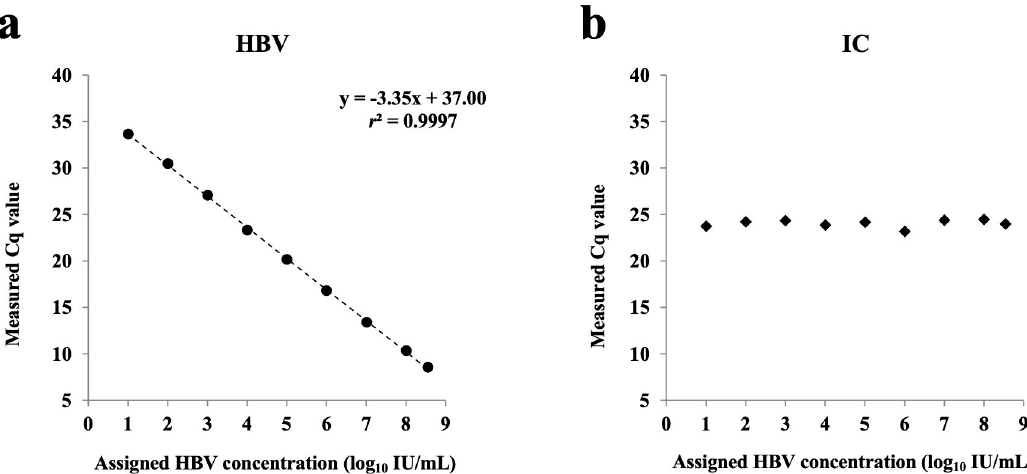
Fig 2. HBV Cq and IC Cq values plot. 3.5 × 10 8 , 10 8 , 10 7 , 10 6 , 10 5 , 10 4 , 10 3 , 10 2 , and 10 IU/mL of the HBV-positive control in the serum were tested using the μ TASWako g1 Analyzer. One replicate for each concentration. PCR efficiency of HBV target amplification was